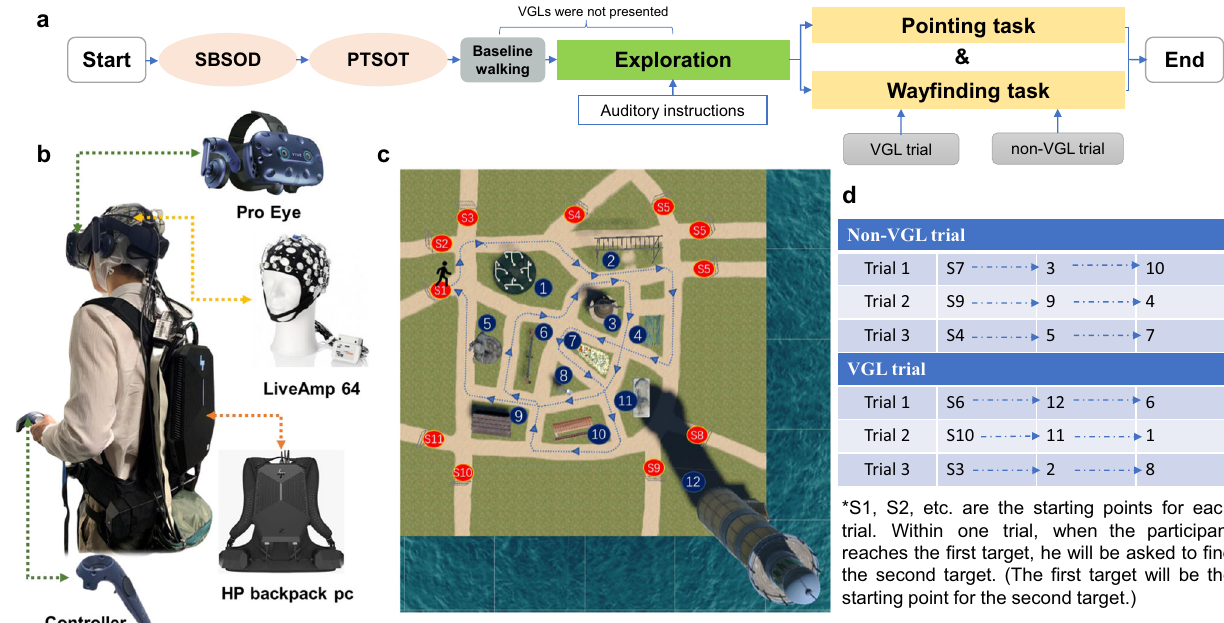
Fig. 5 Experiment procedure. a Overview of the experimental procedure design. First, the participants completed a Santa Barbara Sense of Direction questionnaire about their sense of direction and a Perspective Taking/Spatial Orientation Task, which assesses spatial orienting ability. They were then asked to walk in a square meadow for fi ve minutes. Next, each subject started walking through Sydney Park along a fi xed route with auditory instructions. Global landmarks were not displayed during this exploration phase. Last, the pointing and way fi nding tasks were conducted. b The gear setup for each participant. During the tasks in the VR environment, participants were wearing a 64-channel EEG cap covered by the VR headset with an HP backpack PC on their back and were holding a controller. c A fi xed route map of exploration Auditory instructions were used to guide participants through the route. The plants and trees inside and surrounding the scenario were removed for a clear view of the path. d Trial settings for way fi nding and pointing tasks. For each landmark target, the participant was asked to point to the target (pointing task) before moving toward it (way fi nding task). The number labels for each trial are consistent with the labels in c